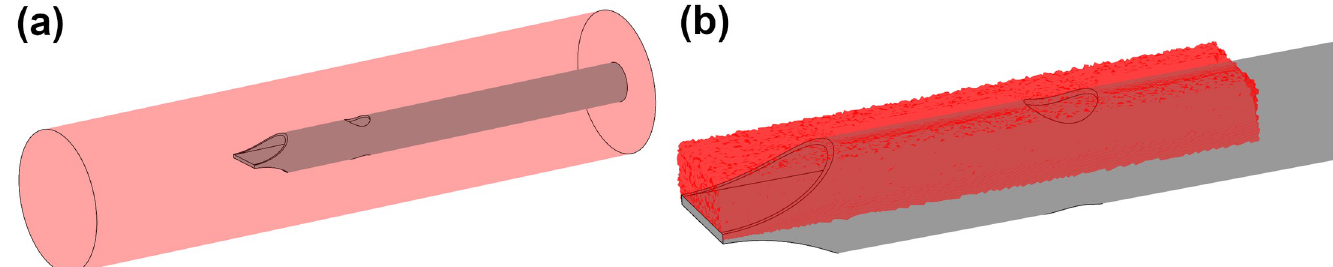
Fig 4. (a) SVC enclosure showing catheter placement, (b) Tip volume for medium sized circular hole. https://doi.org/10.1371/journal.pone.0236946.g004 Platelet modelling. To further analyse the different designs, the path lines of platelets flowing through the side-holes is also considered. Platelets are generated on a tangential plane 1 mm above the surface of the catheter and are tracked through the flow field across steps of 0.5 m. Platelets are modelled as rigid spheres with a diameter [22] of 2 μ m which experience drag modelled by the Schiller-Naumann model [23] (Eq 3) and lift due to shear via the Saffman lift model [24] (Eq 4). Whilst this is the first use of this model applied to platelets, it has been applied to other blood consitiuents and lung particulates with a review of implentations by Kleinstreuer and Feng [25].